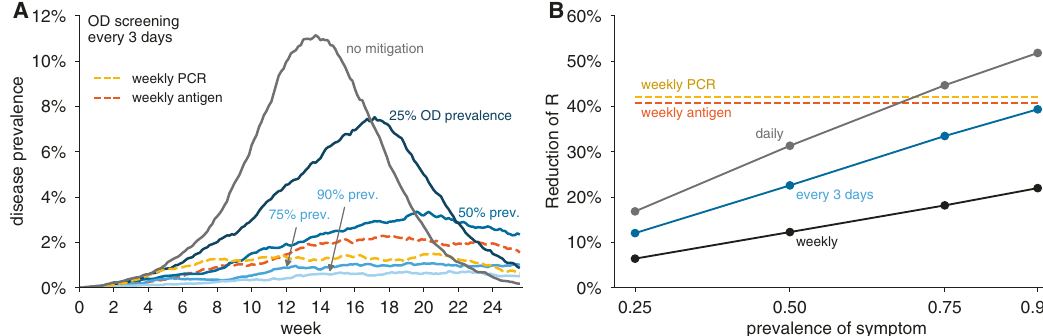
Fig. 1 Impact of olfactory dysfunction prevalence on its effectiveness to limit viral spread. A Examples of viral spread in a community of 20,000 individuals performing olfactory dysfunction (OD) screening every 3 days. No mitigation (black), Prevalence of symptom shown are: 25% (dark blue), 50% (medium blue), 75% (light blue), 90% (lightest blue). In this analysis, olfactory dysfunction is modeled to last 7 days and begin 2 days after viral levels reach ~1000 virions/ml. B Reduction of reproductive number R with different testing regimens showing the impact of symptom prevalence with weekly (black line), every 3 days (blue line), or daily (gray line), testing for olfactory dysfunction. For comparison, weekly RT-PCR testing with a 1 day turnaround (dashed yellow line) and weekly antigen testing (dashed red line) are shown. We consider 80% participation in testing and 20% COVID-19-independent olfactory dysfunction in both